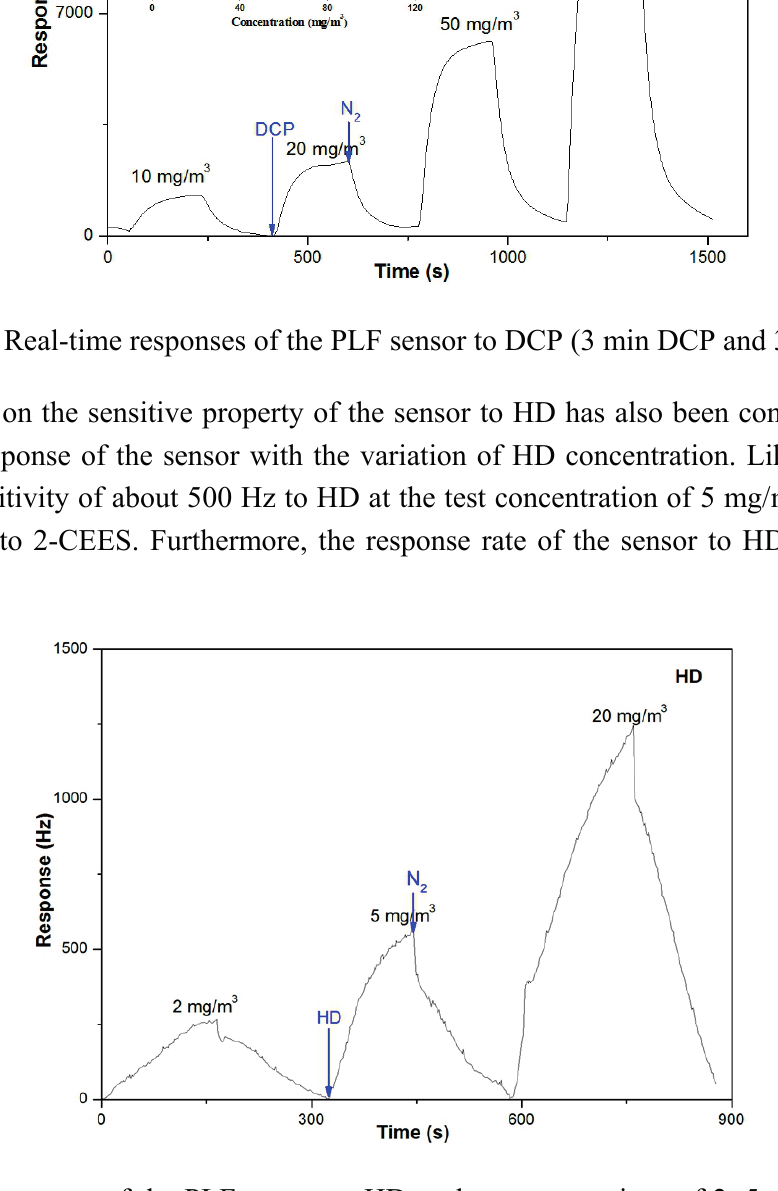
Figure 7. Responses of the PLF sensor to HD at the concentrations of 2, 5 and 20 mg/m 3 (3 min HD and 3 min N 2